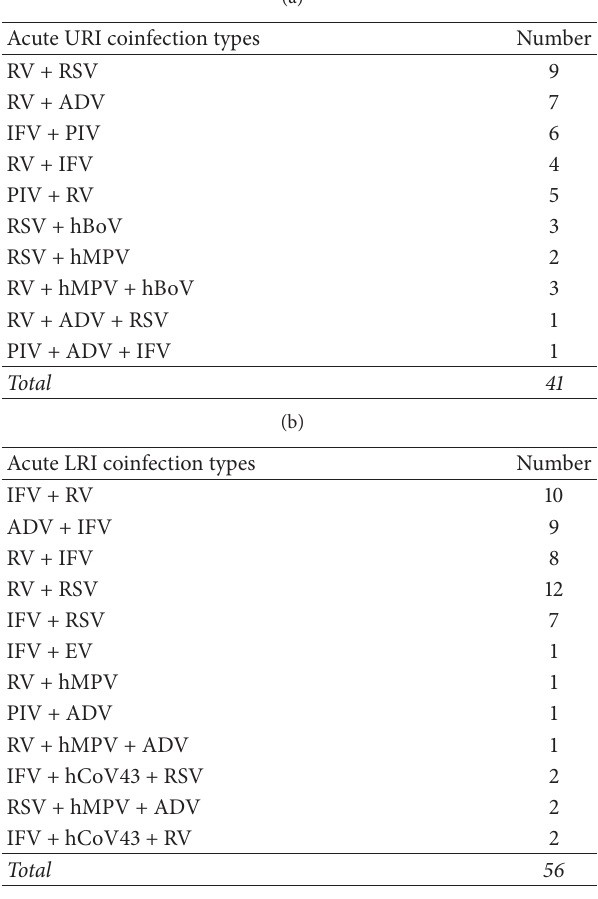
Table 2: Viral coinfection from both acute URIs and